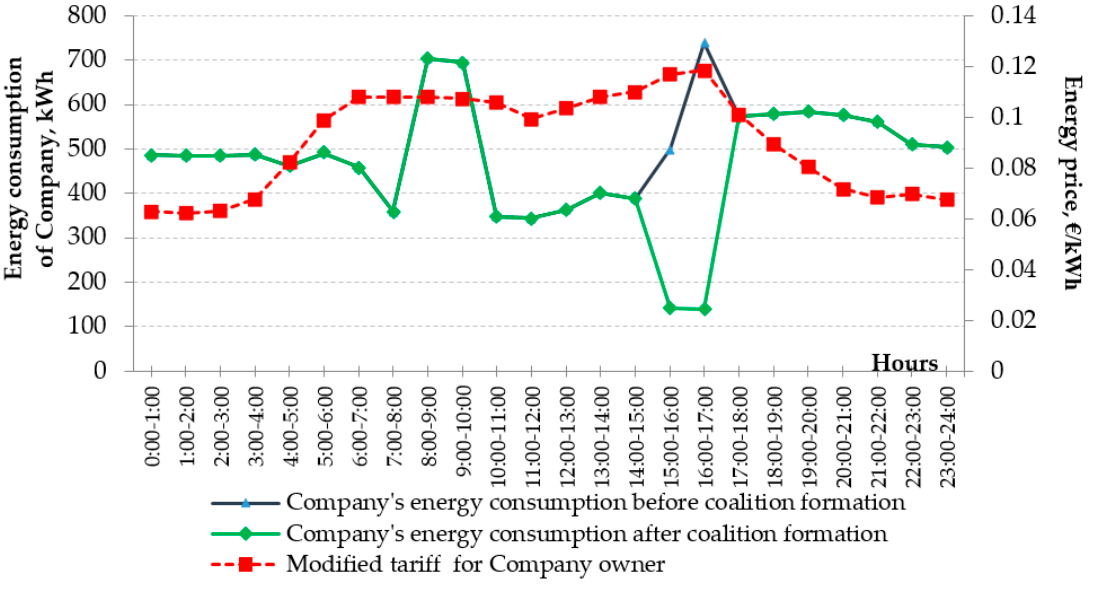
Figure 7. Energy consumption of the company, for one day (6 January 2018), applying the new billing system. The batteries are discharged during the hours of maximum market